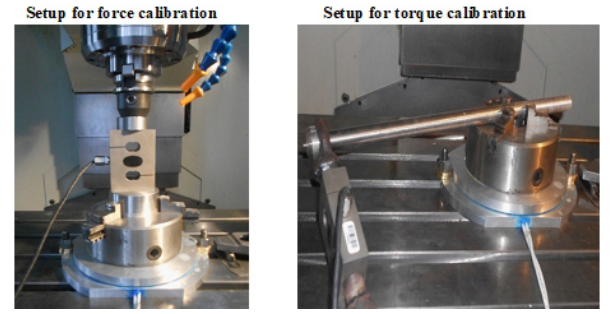
Figure 13. Calibration setup of the sensor to measure the force and